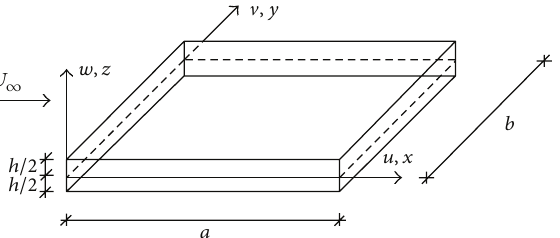
Figure 1: Scheme of the composite panel excited by turbulent flow.